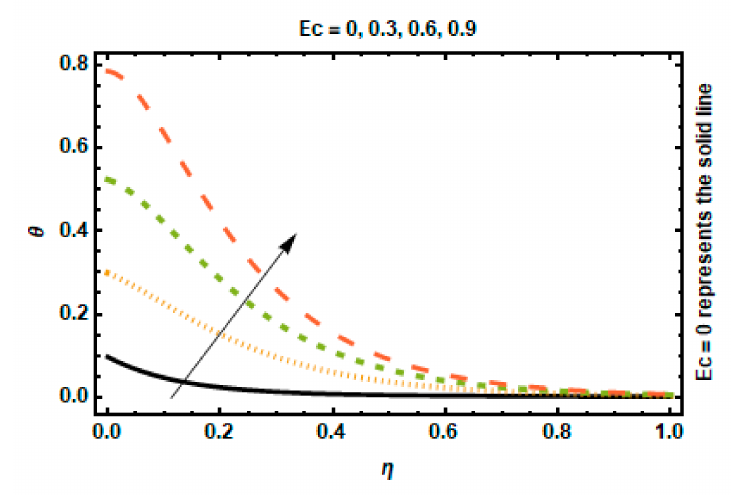
Figure 7. Effects of Ec on temperature.